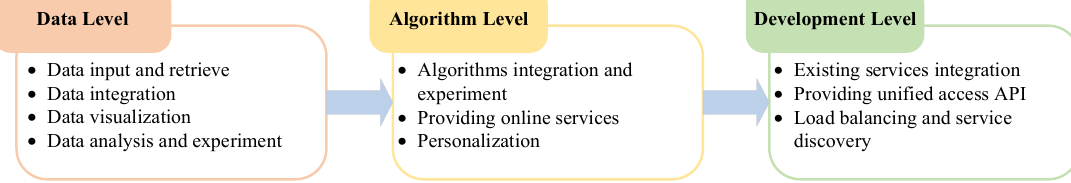
Figure 10. Design of platform application modes. Different levels have different requirements and application modes.